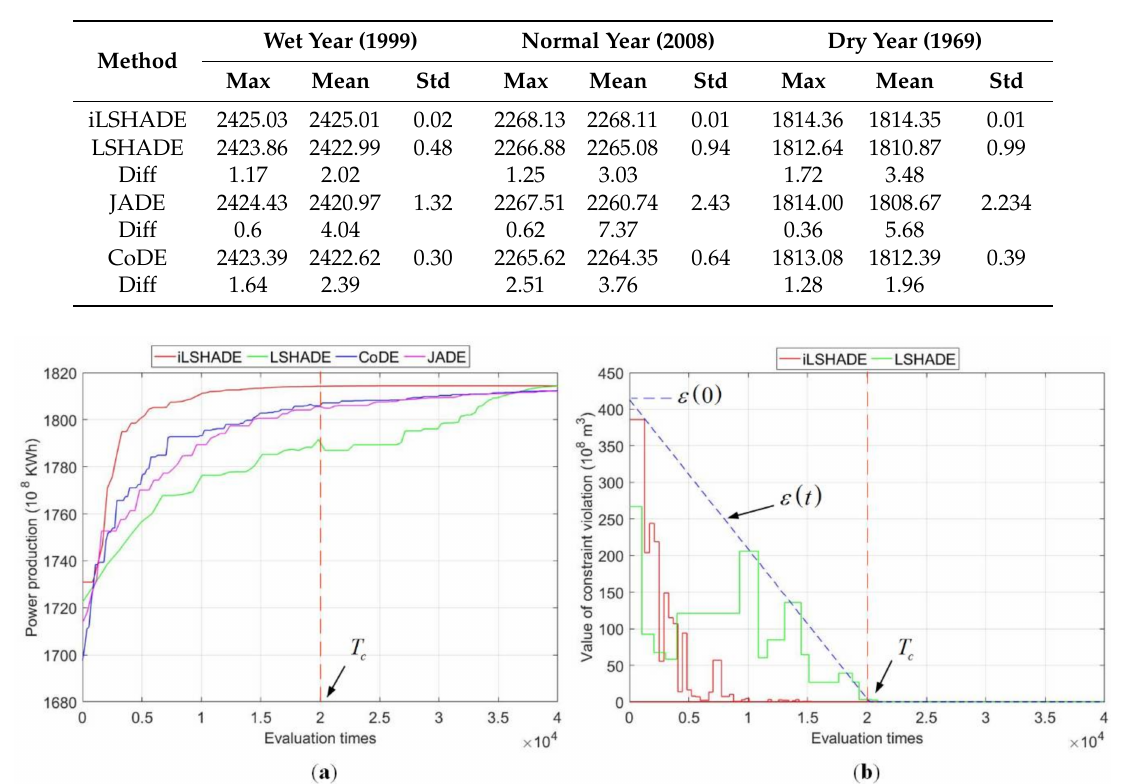
Table 5. Results of 51 independent simulations on generated energy optimization (10 8 KWh).